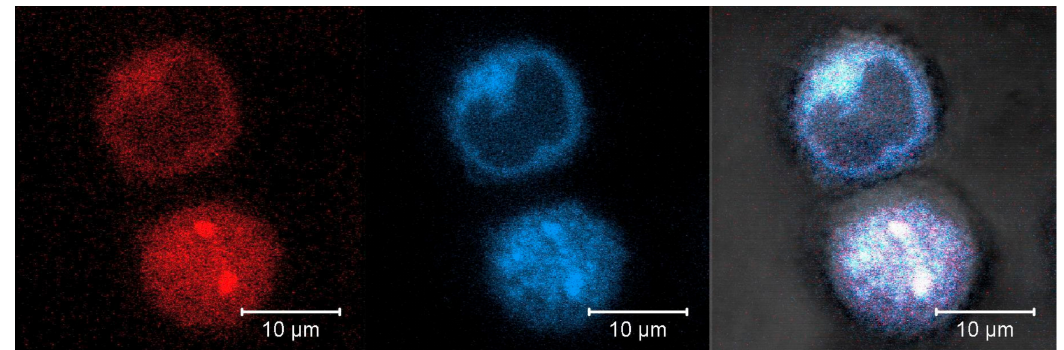
Figure 9. Representative CLSM images in fluorescence, transmission and overlay modes of A549 cells after 24 h culturing with DOX-HSA-MPs (5000 particles / cell) and Lysotracker ® Deep Red staining. Fluorescence modes was accessed with excitation at 488 nm and band pass emission filter 530 / 600 nm for DOX (red color) and excitation at 633 nm and long pass emission filter 650 nm for Lysotracker ® Deep Red (blue color).